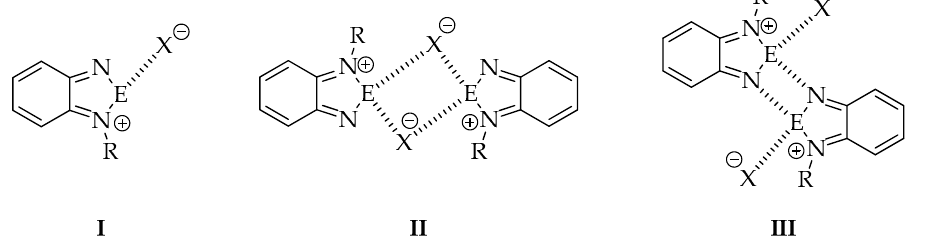
Figure 2. Most common motifs observed in crystals of N ‐ alkyl ‐ 2,1,3 ‐ benzochalcogenadiazolium salts.